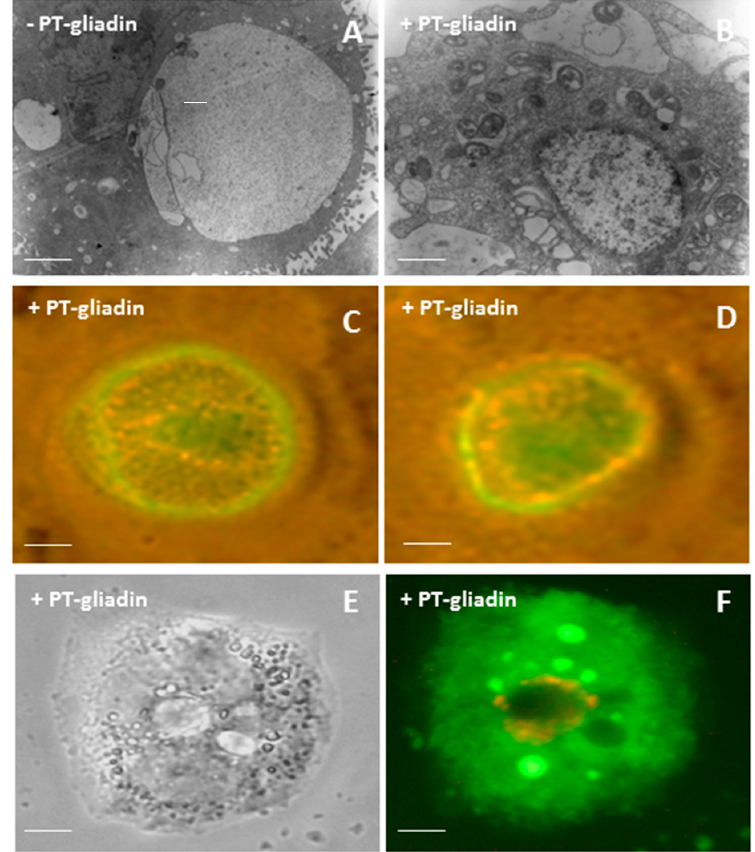
Figure 5. Ultrastructural and molecular characterization of intracellular large vesicles after PT-gliadin administration in Caco-2 cells. ( A , B ) TEM analysis of Caco-2 cells at 24 h after PT-gliadin administration (1 µg/µL) visualized using a Zeiss EM900 electron microscope. Scale bars = 2 µm. ( C , D ) Caco-2 cells incubated with PT-gliadin as above were transduced with the Premo Autophagy Sensor LC3B-GFP system, according to the guidelines and visualized using an inverted microscope Eclipse Nikon TS100, 100× oil immersion Plan Fluor objective. Scale bars = 2 µm (computer magnification); ( E , F ) For intra-vesicular pH content of Caco-2 vesicles, after PT-gliadin administration (1 µg/µL for 24 h), cells were incubated with acridine orange (1 µg/mL) for 10 min. Cells were then visualized under the optical microscope and using an inverted microscope Eclipse Nikon TS100, 40×, respectively. (scale bars = 10 µm).